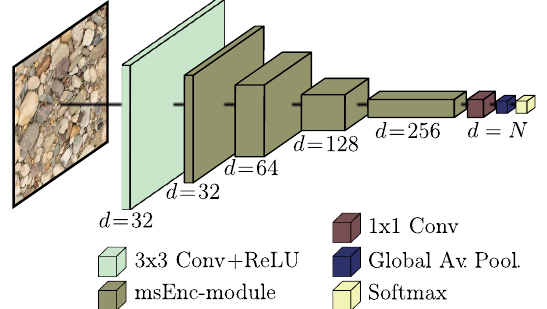
Figure 2. High-level overview on the AggNet architecture proposed in this work for grading curve